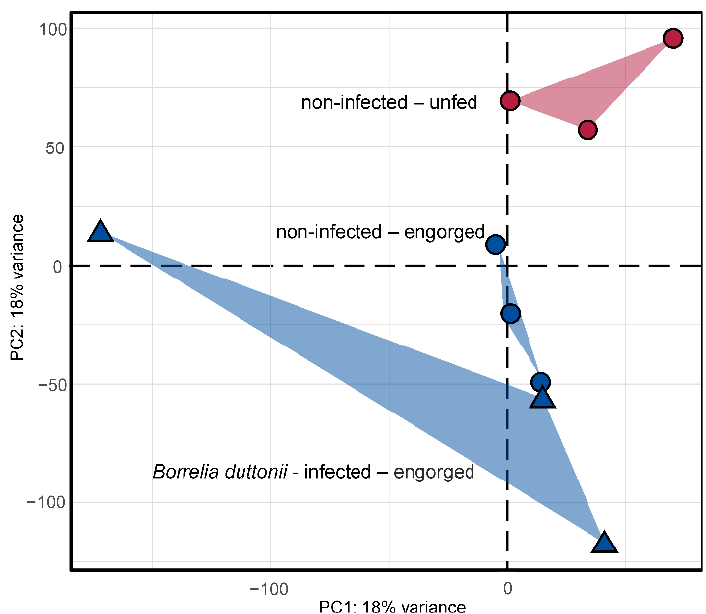
Figure 2. Principle components analysis for a subset of 2000 transcripts showing the highest variance within the dataset. Read counts were normalized using the regularized log transformation prior to analysis. Samples from non-infected and Borrelia duttonii -infected samples are highlighted with circular or triangle shapes, respectively. Samples from O. moubata ticks that have either been allowed to fed to repletion or unfed are colored in blue and red, respectively.